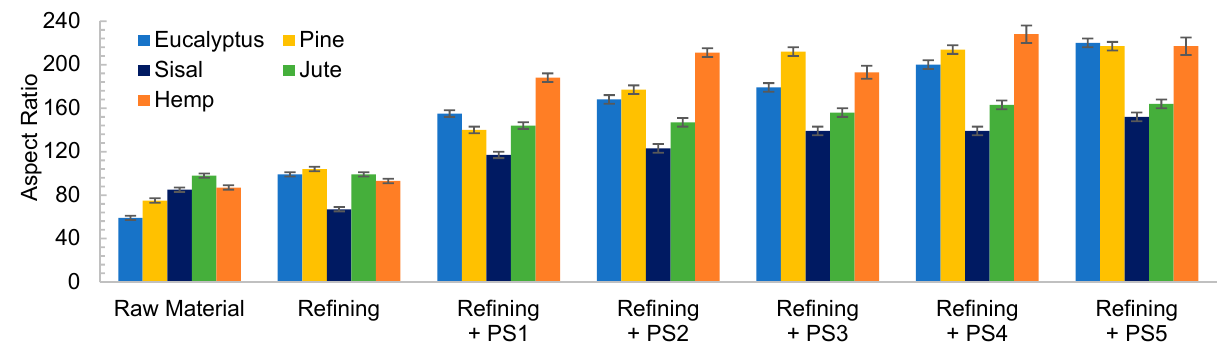
Figure 2. Evolution of aspect ratio when a refining pretreatment and different pressure sequences are used to produce CMF/CNFs.